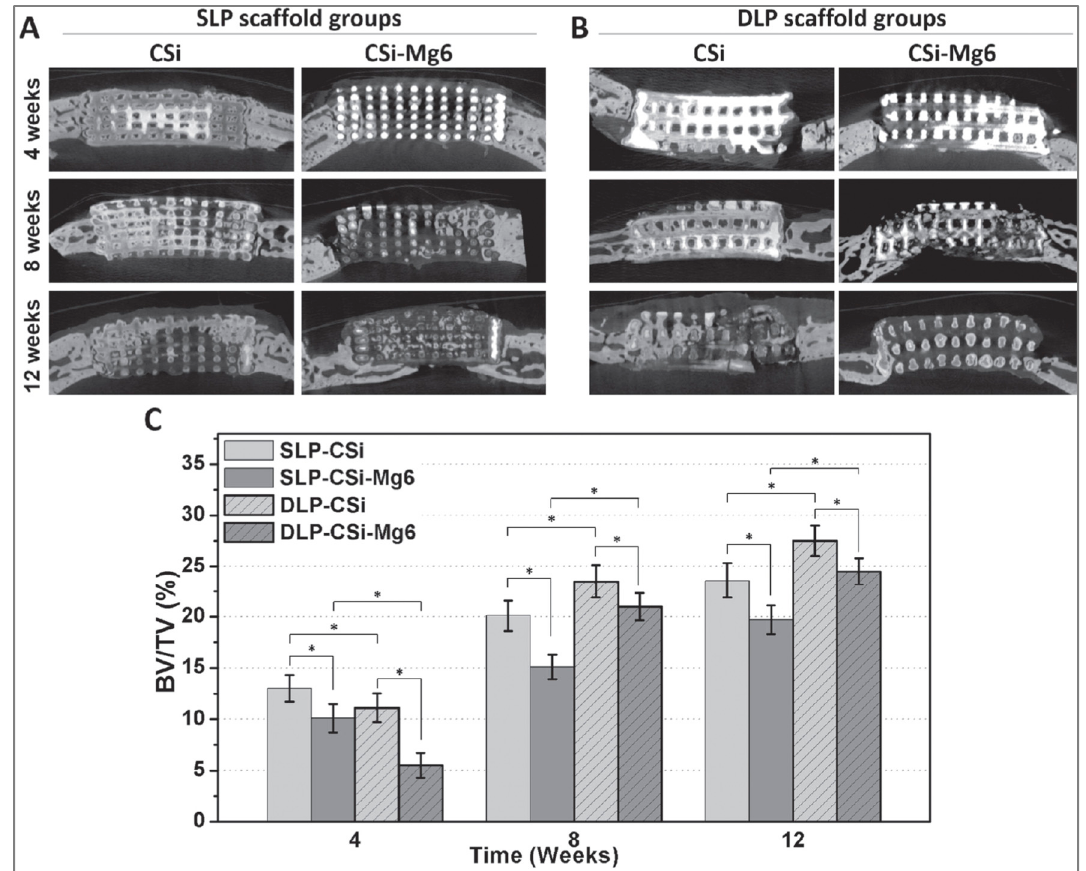
Figure 2. Osteogenesis of the ceramic scaffolds in vivo. ( A ) The cross-sectional images of implanted ceramic scaffolds of CaSi and CaSi–Mg6 with single layer pore morphology by microCT scanning after 4, 8, and 12 weeks, respectively. ( B ) The cross-sectional images of implanted ceramic scaffolds of CaSi and CaSi–Mg6 with double layer pore morphology by microCT scanning after 4, 8, and 12 weeks, respectively. ( C ) Morphometric analysis of the volume of the newly formed bone (BV/TV) in the skull defect area at 4, 8, and 12 weeks with single layer pore morphology and double layer pore morphology, respectively. (*p < 0.05) [116].